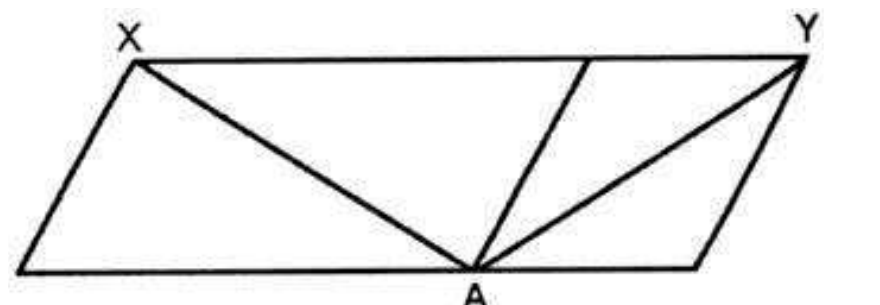
Fig. 4. Sander Parallelogram. Source: Adapted from Deregowski, 1980